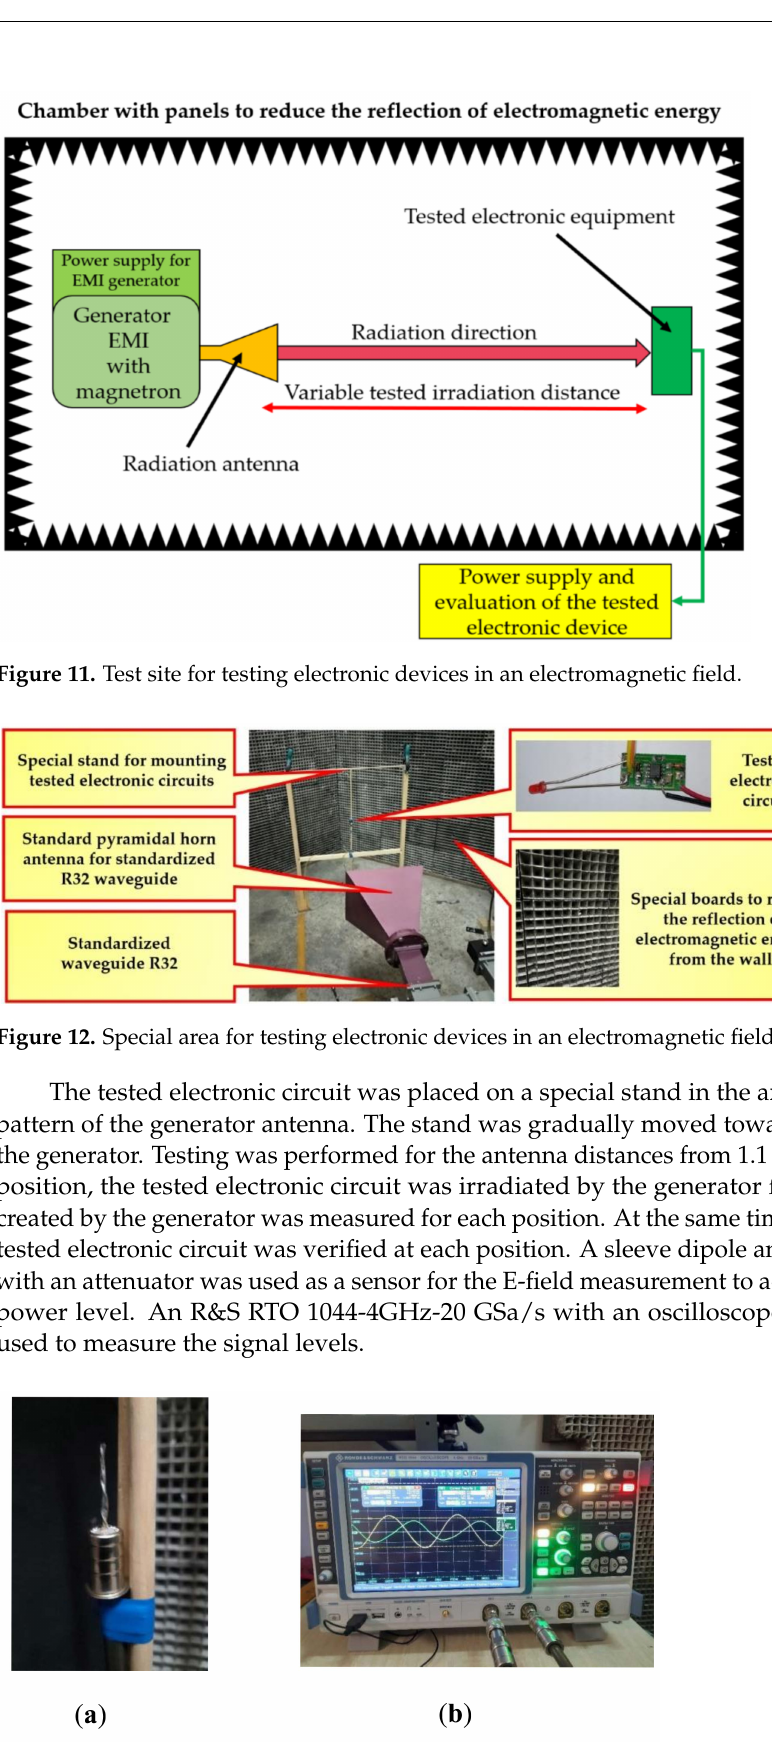
Figure 13. E-field sensor: ( a ) sleeve dipole antenna; ( b ) R&S RTO 1044-4GHz-20 GSa/s